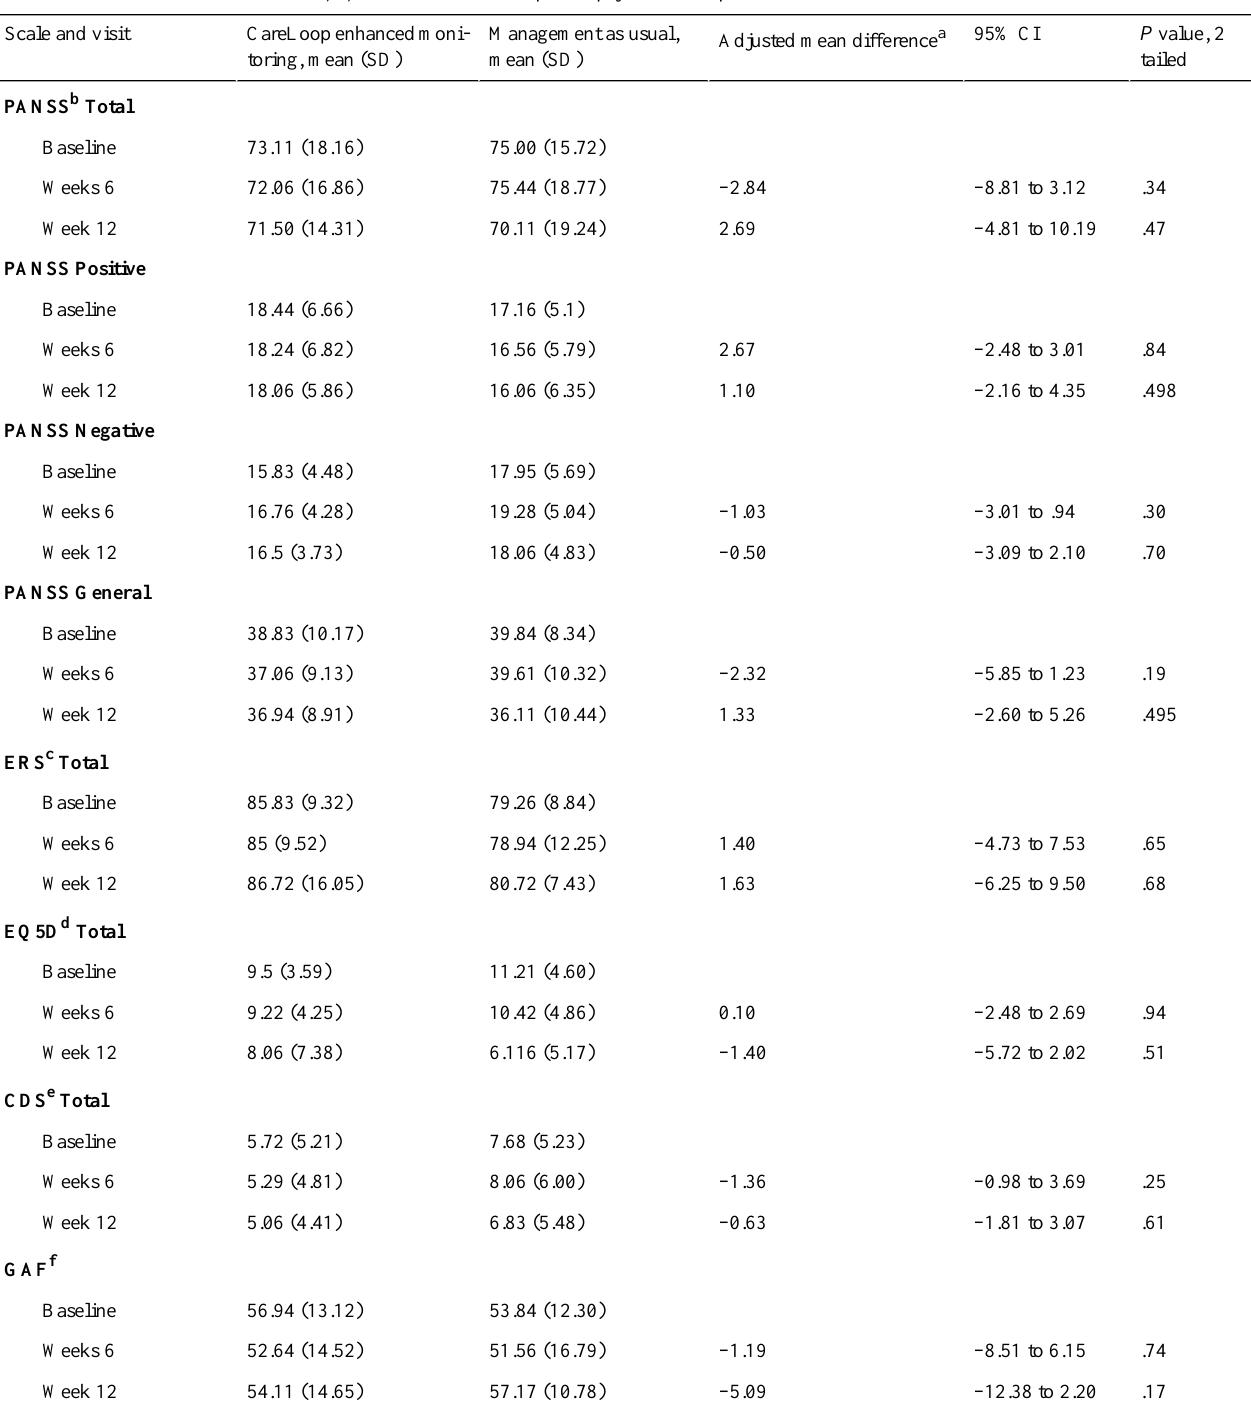
Table 5. Clinical measures at baseline, 6, and 12 weeks: First episode psychosis